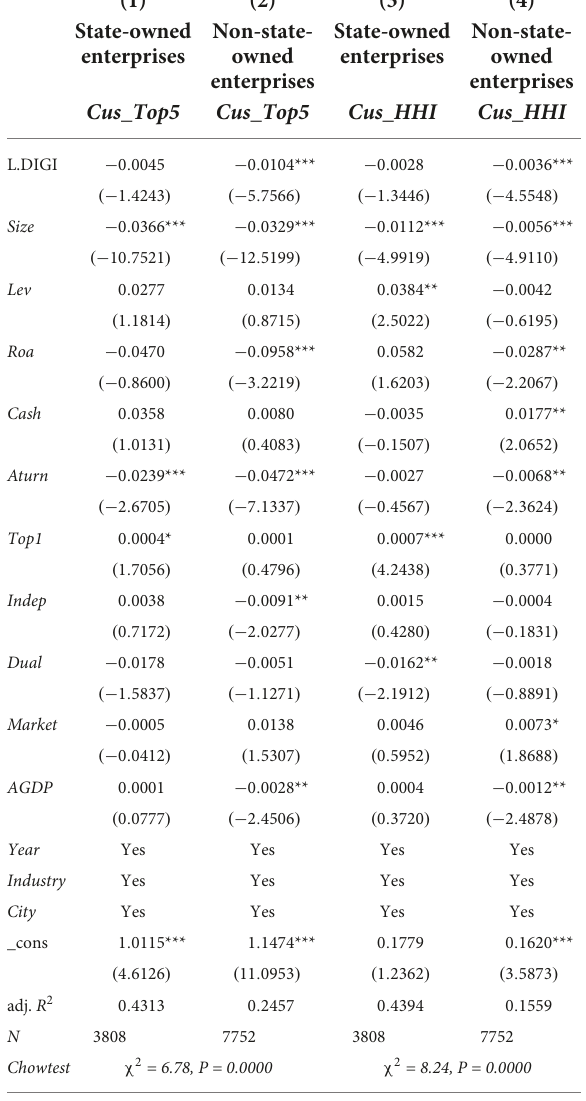
TABLE 10 Heterogeneity test of the nature of corporate property